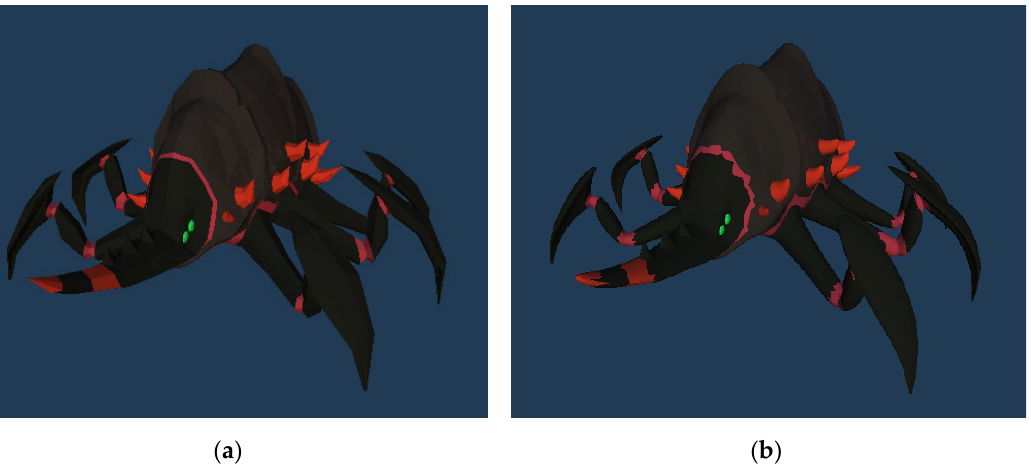
Figure 9. ( a ) Red enemy model from the improved version of the game. ( b ) Red enemy model from